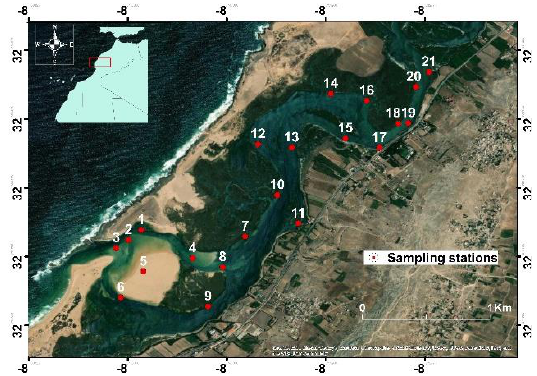
Figure 1. Location of sampling stations in Sidi Moussa Lagoon